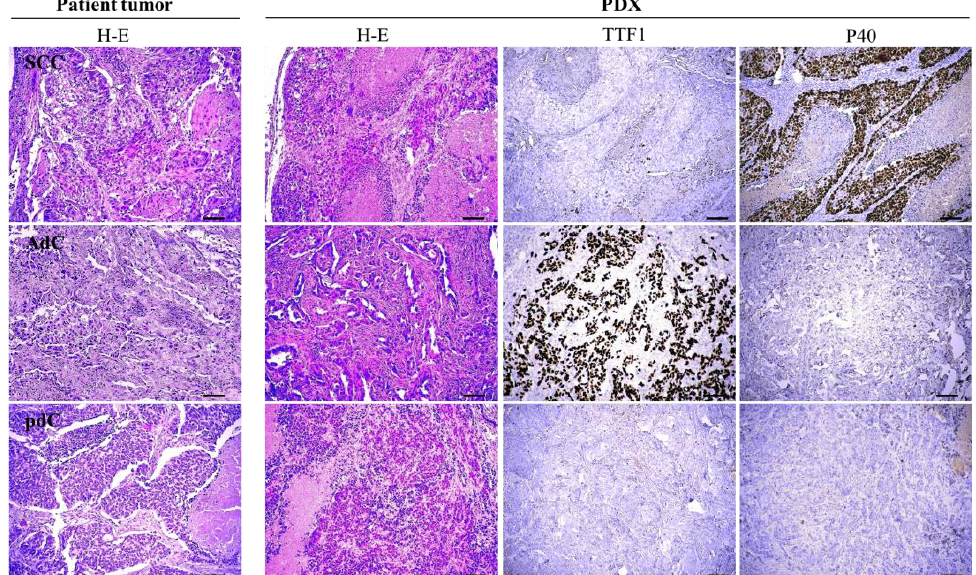
Figure 1. Histological evaluation of primary tumors and PDX. Images from eosin and hematoxylin staining (H/E) from a representative example of squamous cell carcinoma (SCC), adenocarcinoma (AdC), and a poorly differentiated carcinoma (pdC) showing that the mouse tumor preserved the morphological features of the primary tumor. The squamous cell marker P40 and the adenocarcinoma marker TTF1 were also used on the PDX tumor. Scale bar: 100 μm.